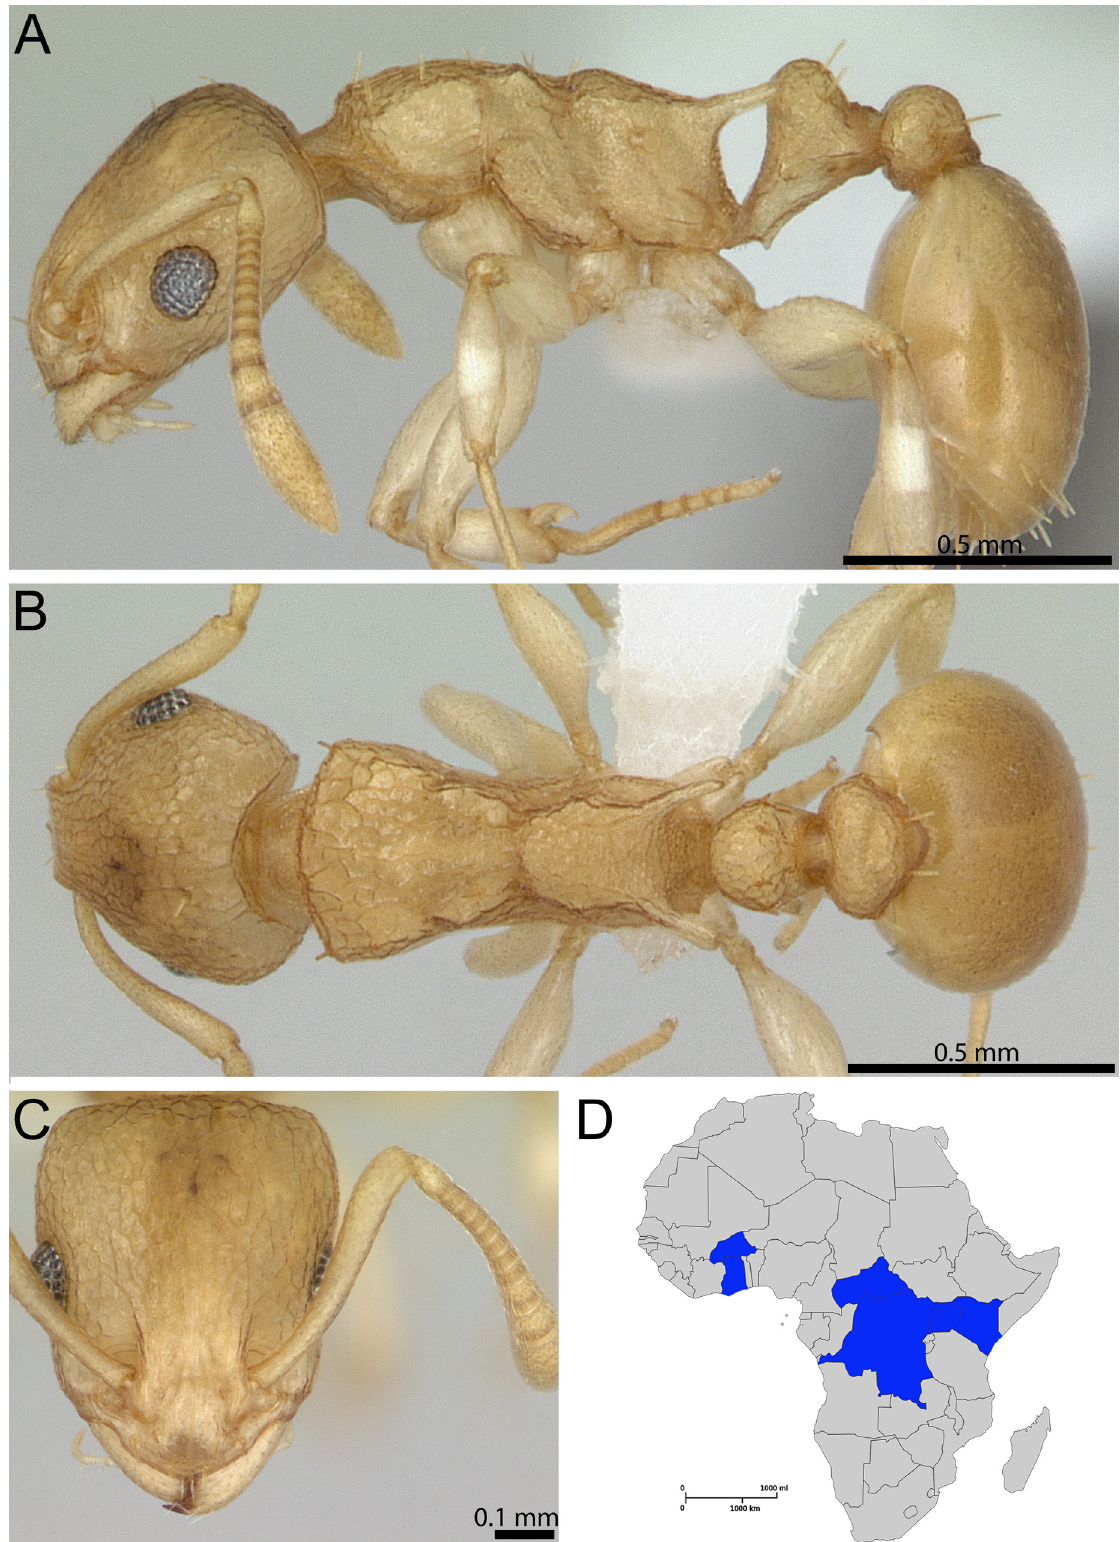
Fig. 16. Nesomyrmex evelynae (Forel, 1916) (CASENT0413068). A . Body in profile view. B . Body in dorsal view. C . Head in full-face view. D . Map of Africa and Madagascar showing currently known